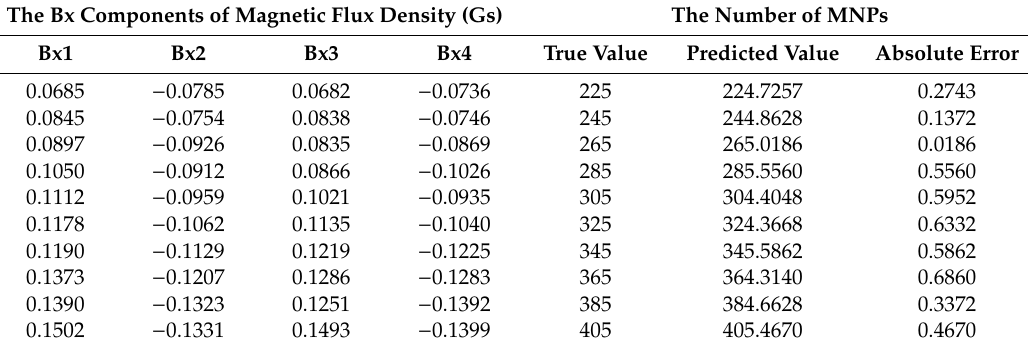
Table 8. Partial prediction results of the number of MNPs through the simulated annealing neural network model.